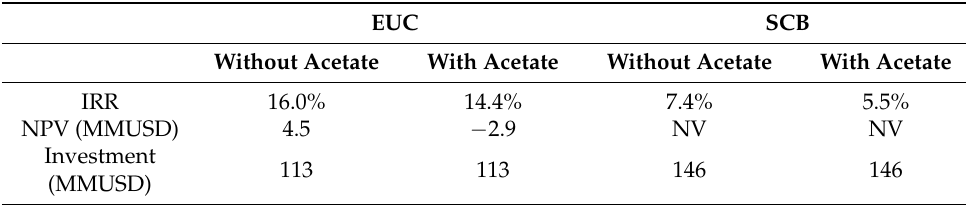
Table 5. Economic indicators for scenarios evaluated.